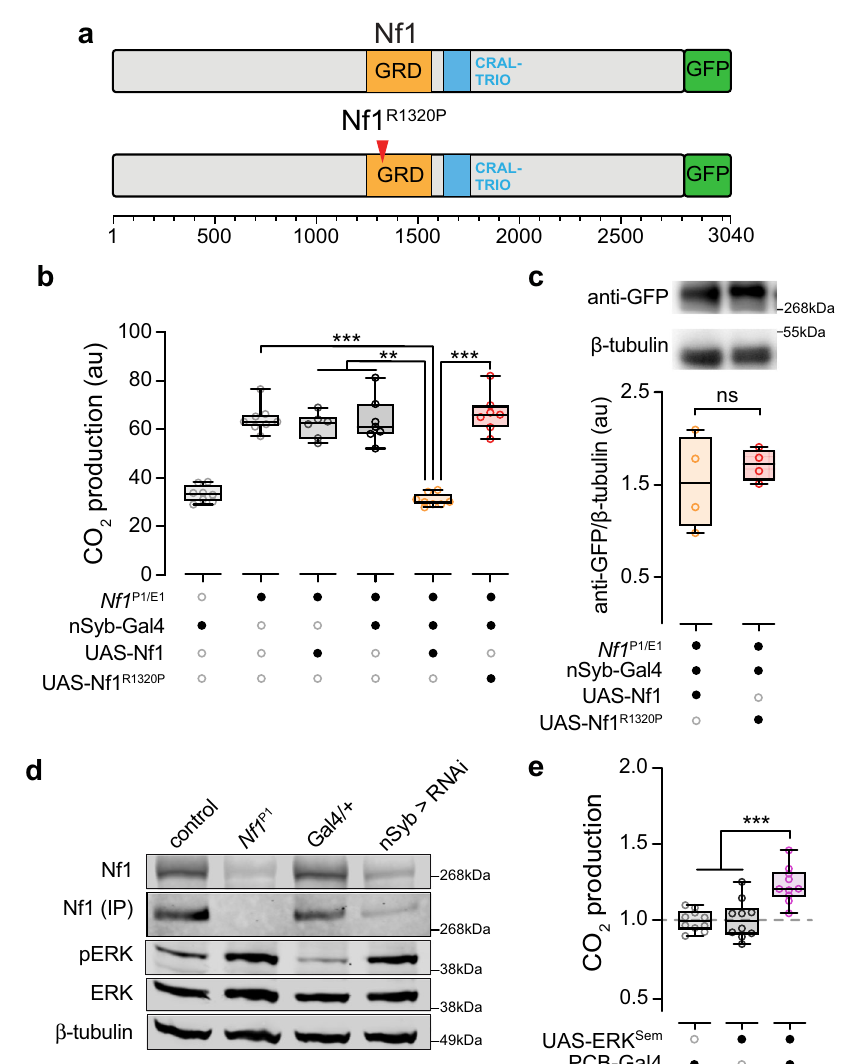
Fig. 7 Nf1 metabolic effects are rescued by full-length Nf1 and require a functional GAP-related domain (GRD). a Major domains in neuro fi bromin (GRD and CRAL-TRIO), site of the R1320P mutation (red arrow), and GFP C-terminal fusion. b Transgenic expression of full-length Nf1 and Nf1 R1320P in the heteroallelic Nf1 P1/E1 mutant background. Full length Nf1 rescues CO 2 production to nSyb-Gal4/ + levels. Experimental (UAS-Nf1; nSyb-Gal4, Nf1 P1/E1 ) *** p = 0.001 re: Nf1 P1/E1 , ** p = 0.009 re: UAS-Nf1; Nf1 P1/E1 , ** p = 0.005 re: nSyb-Gal4, Nf1 P1/E1 , *** p = 0.0003 re: UAS-Nf1 R1320P ; nSyb-Gal4, Nf1 P1/E1 . (Dunn ’ s test, two-sided; n = 8 nSyb-Gal4/ + , n = 8 Nf1 P1/E1 , n = 6 UAS-Nf1; Nf1 P1/E1 , n = 7 nSyb-Gal4, Nf1 P1/E1 , n = 8 UAS-Nf1; nSyb-Gal4, Nf1 P1/E1 , n = 7 UAS-Nf1 R1320P ; nSyb-Gal4, Nf1 P1/E1 ). c Representative western blot of anti-GFP and β -tubulin shown. Samples derived from the same experiment and processed in parallel. Blot normalized to the intensity of loading control ( β -tubulin). Quanti fi cation represents four replicates. au: arbitrary units, ns: